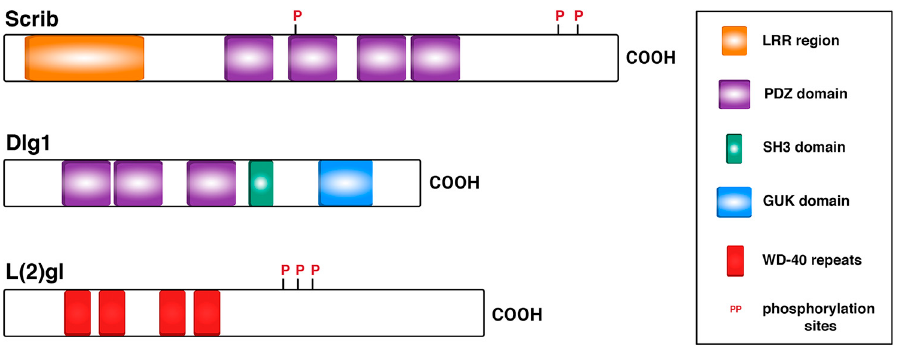
Figure 1. The Scribble polarity module. The modular structure of the proteins belonging to the Scribble module, Scrib, Dlg1, and L(2)gl, is shown. The LAP (Leucine-rich repeats Aand PDZ domains) protein Scrib and the MAGUK (Membrane Associated GUanylate Kinase) protein Dlg1 both contain PDZ domains and additional motifs, such as 16 Leucine-Rich-Repeats (LRRs, in Scrib) or a Src Homology 3 and a GUuanylate Kinase (SH3 and GUK domains, in Dlg1). L(2)gl contains WD-40 repeats. Conserved phosphorylation sites are shown in both L(2)gl and Scrib.